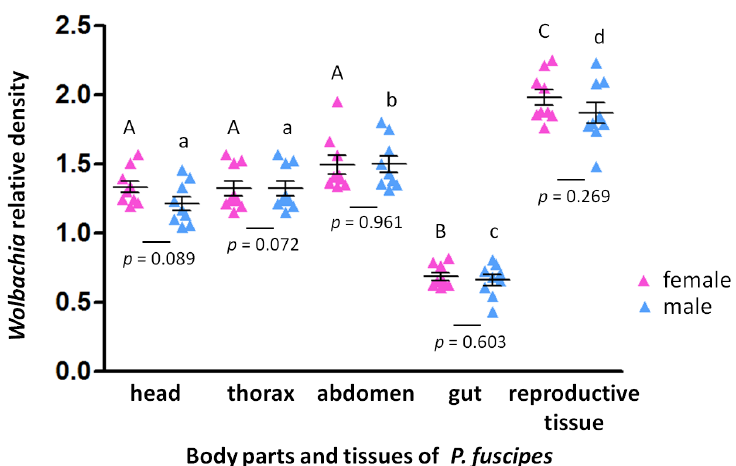
Figure 3. Relative Wolbachia density was measured across different body parts and tissues. Nine P. fuscipes were tested per treatment. Each data point represents the average of three technical replicates. The bars represent mean ± standard error (n = 9) and the different letters above the scatter dot plot indicate significant difference between developmental stages ( p < 0.05). Uppercase letters represent female while male is represented by lowercase letters.